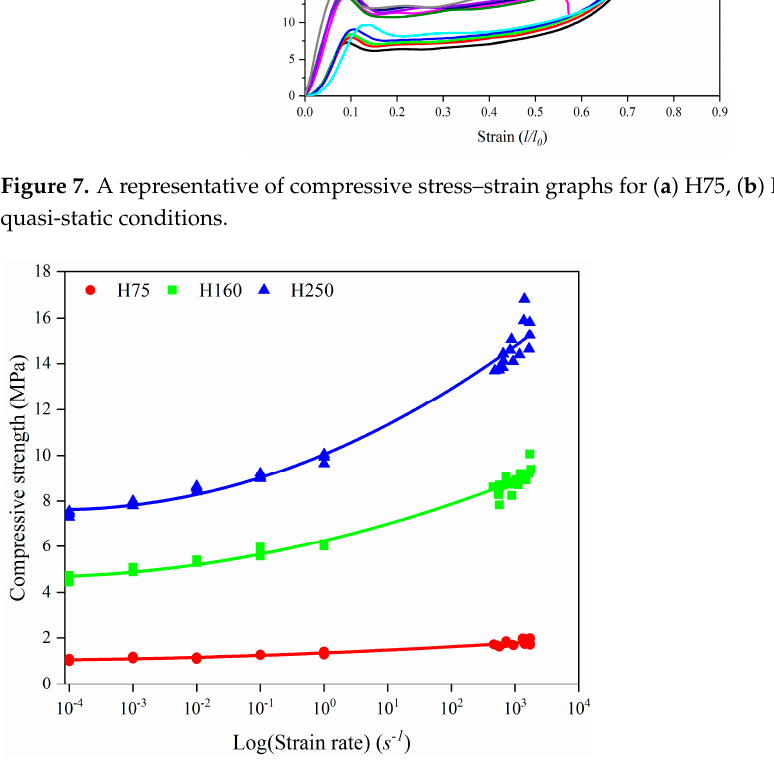
Figure 8. The compressive strength over the strain rate (log scale).